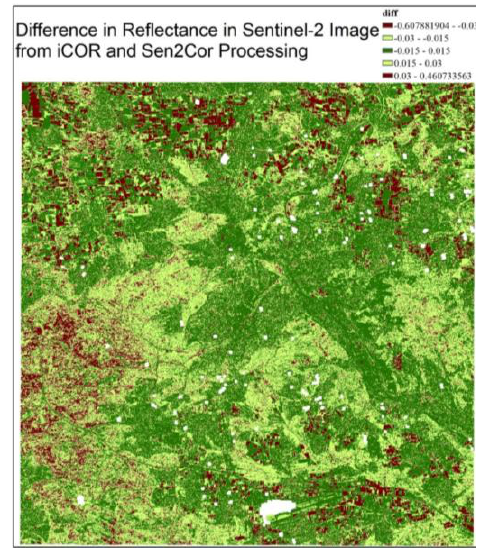
Figure 2. Sentinel-2: iCOR and Sen2Cor reflectance value differences.